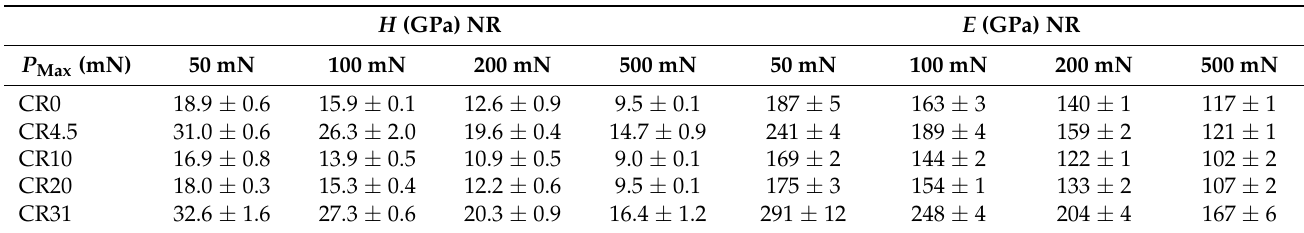
Table 1. H and E values of the NR plane in CR0, CR4.5, CR10, CR20, and CR31 at different P max values in between 50 and 500 mN.